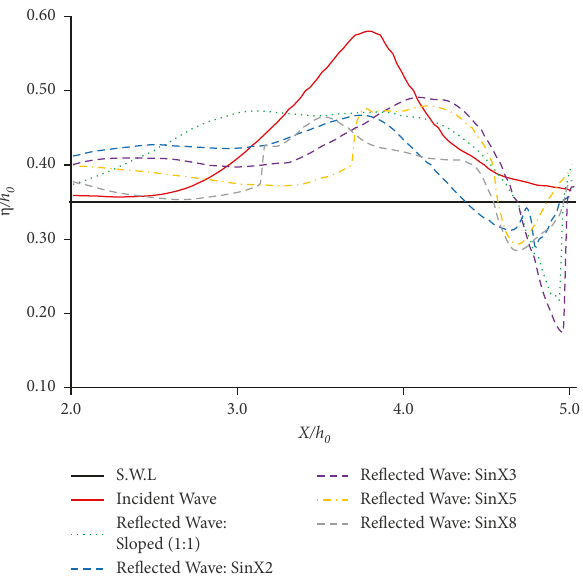
Figure 15: The incident wave and relevant reflected waves from sloped and sinusoidal walls ( H / h 0 : 0.7).